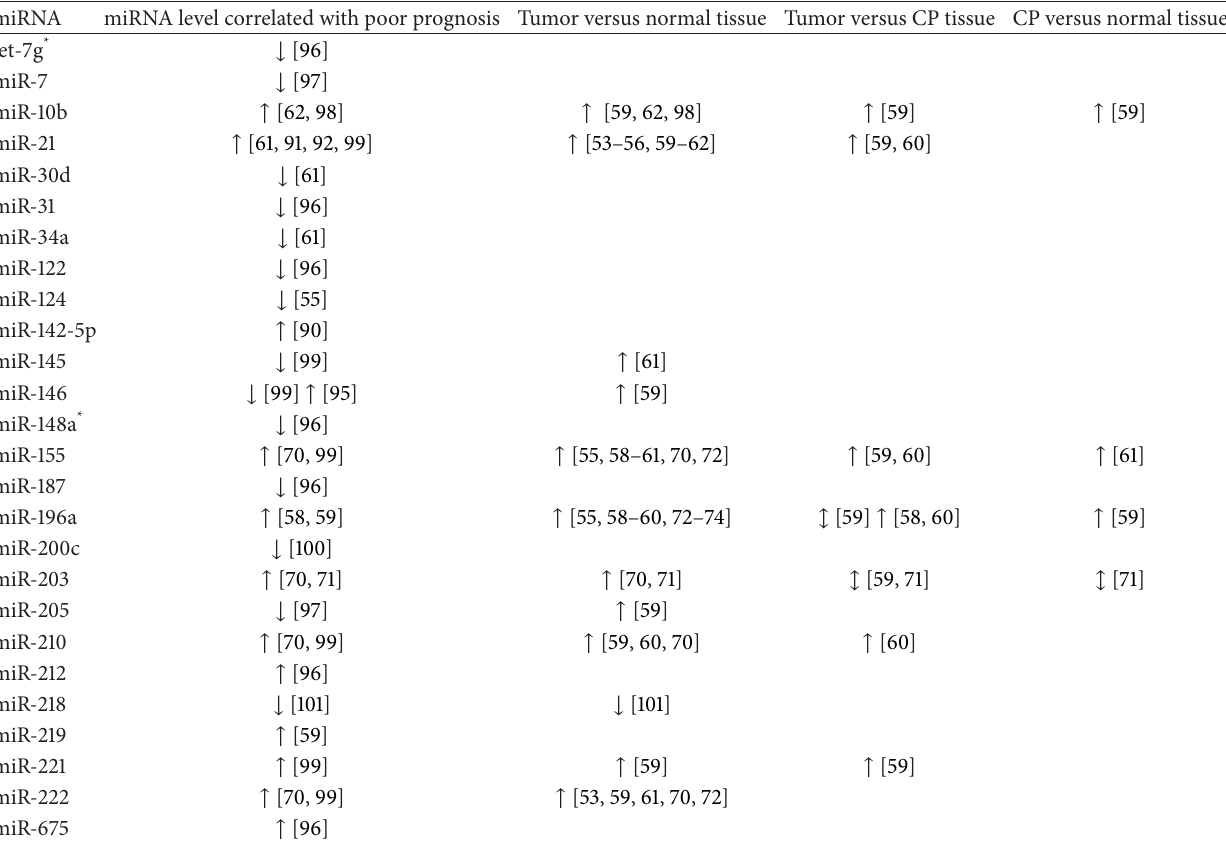
Table 3: Prognostic miRNAs expression ( ↓ reduced, ↑ increased, and ↕ comparable expression).